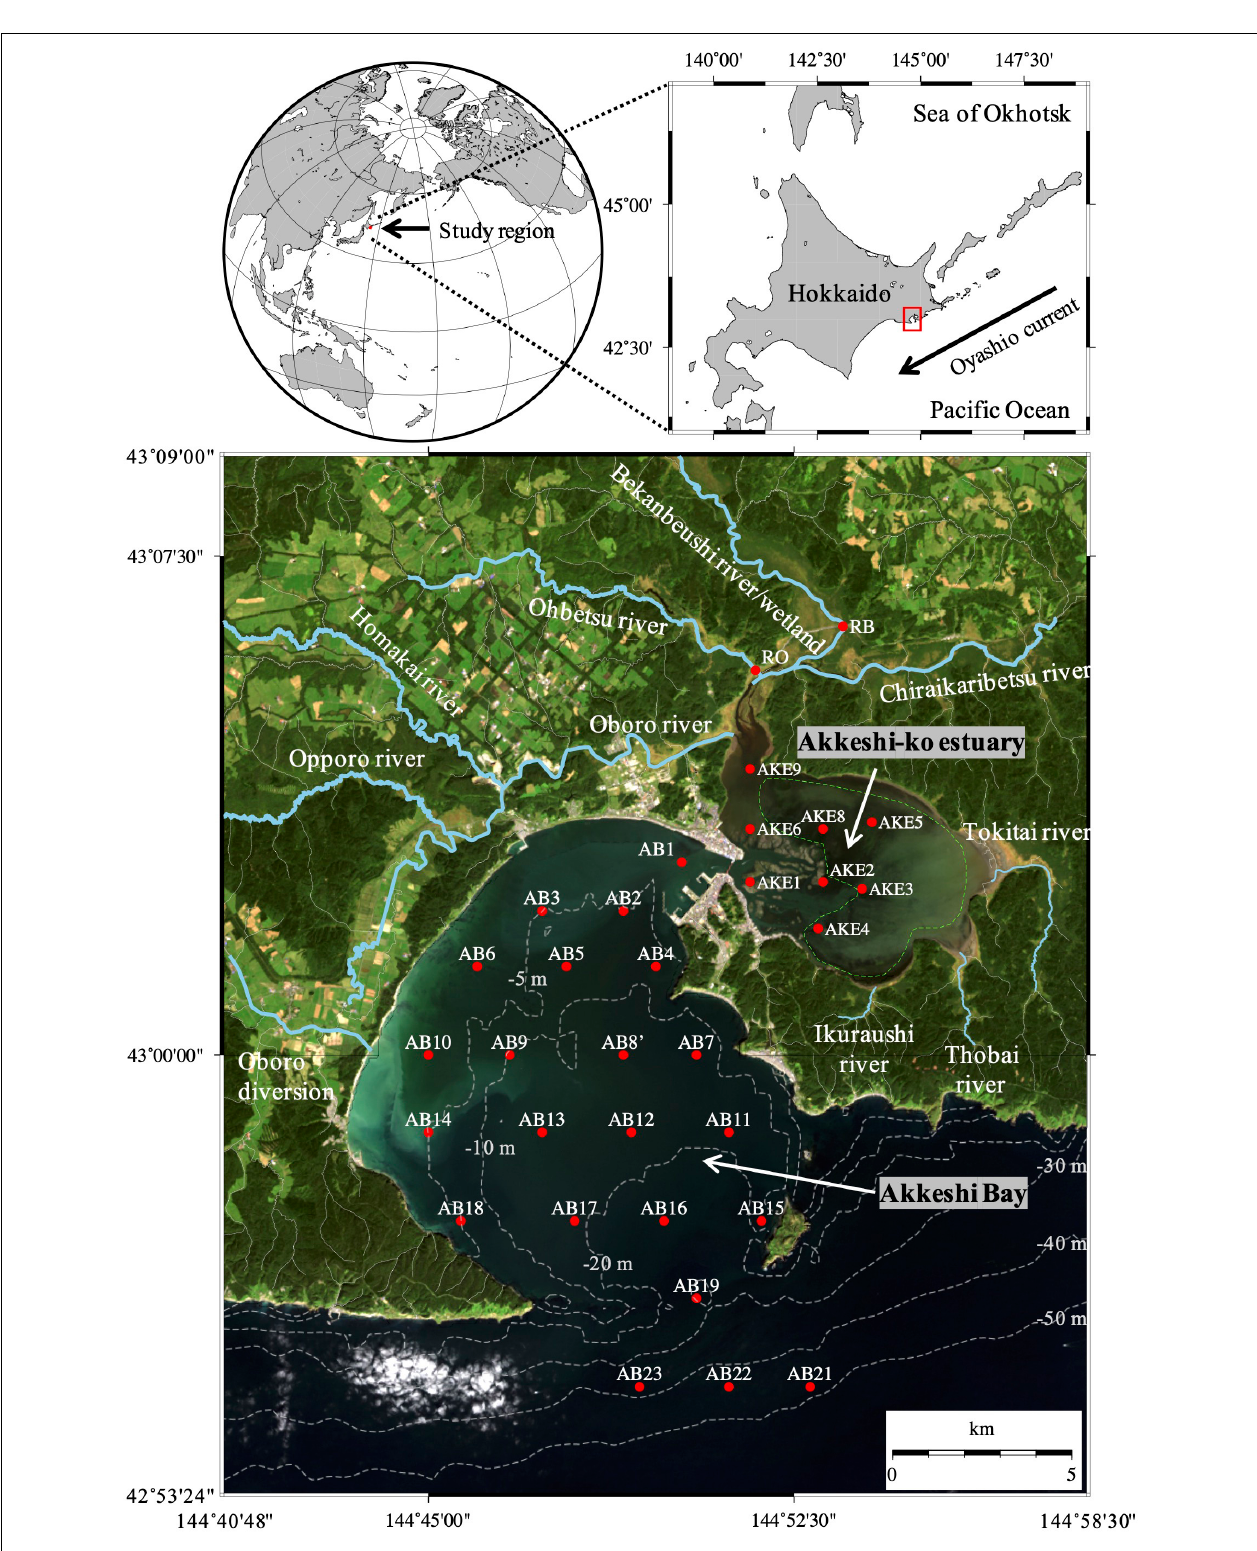
FIGURE 1 | Sampling stations in the rivers (RO and RB), Akkeshi-ko estuary (AKE), and Akkeshi Bay (AB) superimposed on a quasi-true color image derived from Landsat 8 (USGS/NASA) on September 22, 2014. Area enclosed by the green dashed line in AKE represents the eelgrass ( Zostera marina ) meadow after Hasegawa et al.